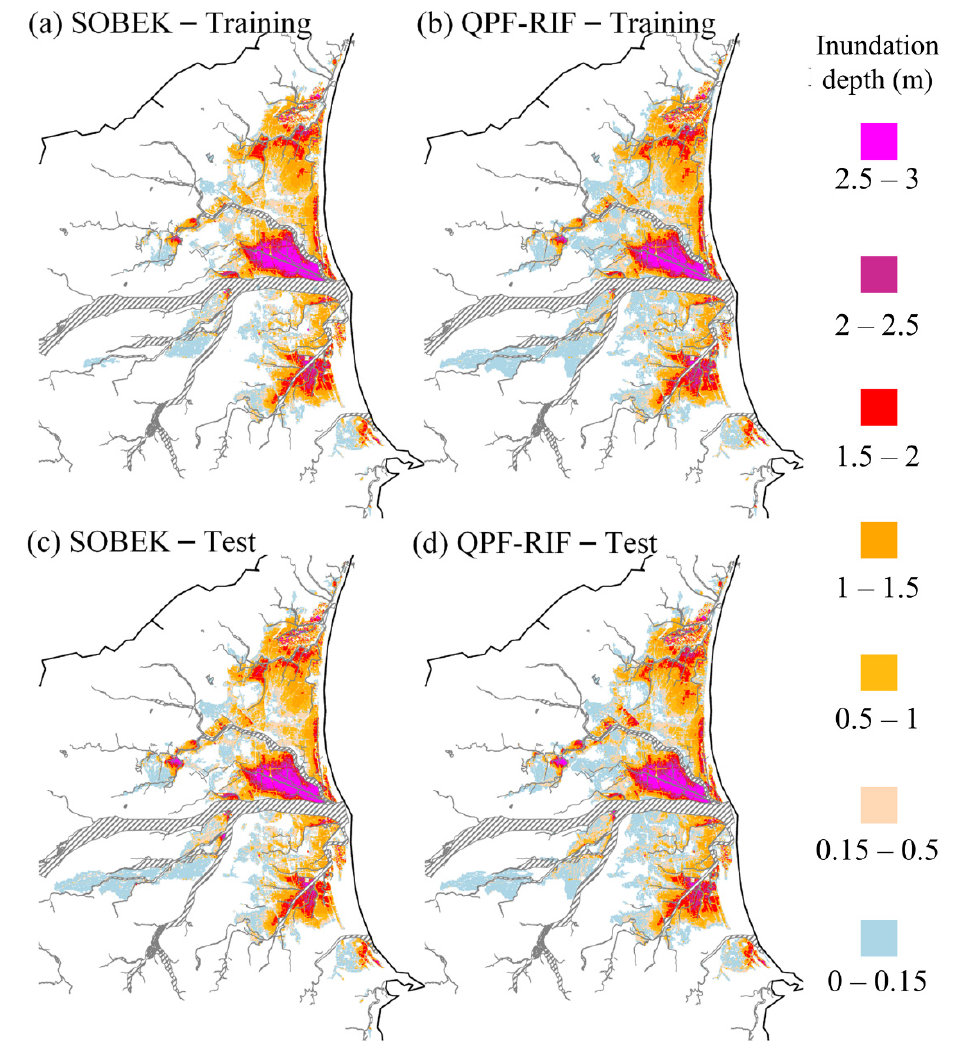
Figure 10. Comparing the flooding maps simulated by SOBEK and forecasted by QPF-RIF in the training and testing phases.